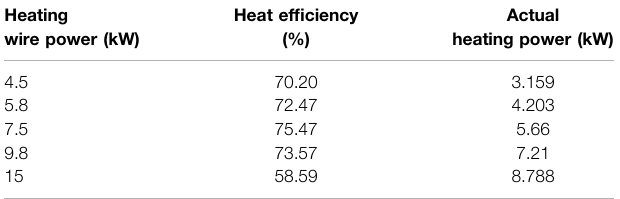
TABLE 3 | Heating power and heat ef fi ciency to the heating section.